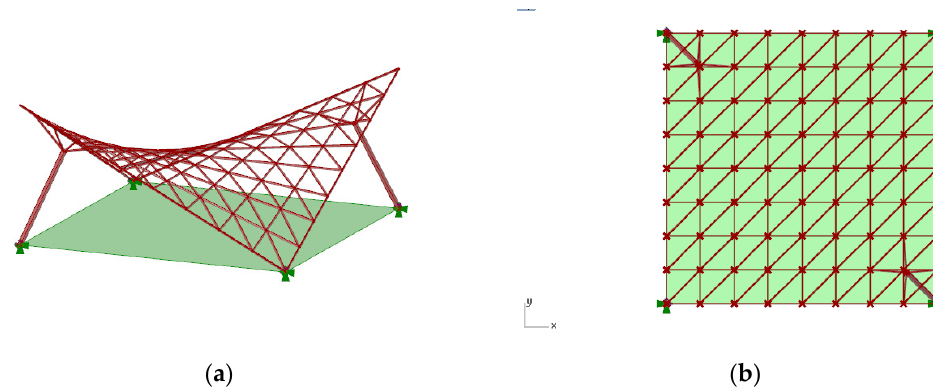
Figure 4. The hyperbolic paraboloid structure of type a (with a grid division along shorter diagonals): ( a ) an axonometric view; ( b ) an orthographic projection.